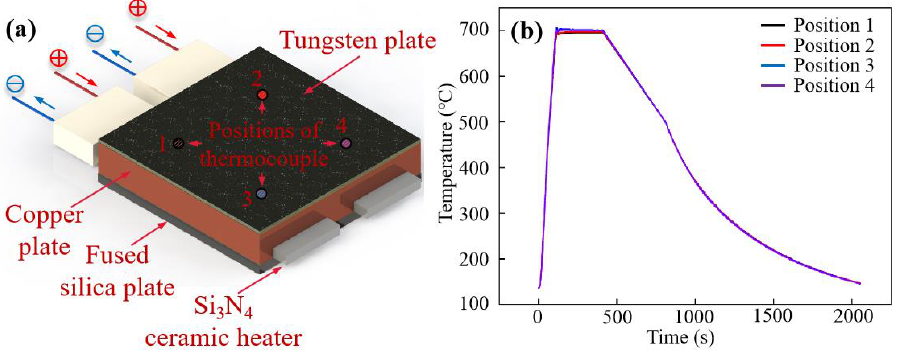
Figure 2. ( a ) Schematic of the rapid heating module and ( b ) the recorded temperature signals at four different positions in the heating test.